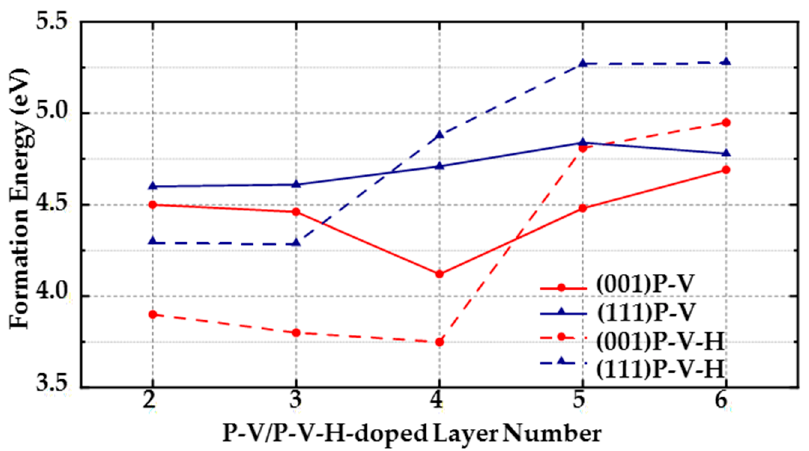
Figure 6. The lowest formation energies of PV and PVH complexes in each layer in (001) and (111) surface.